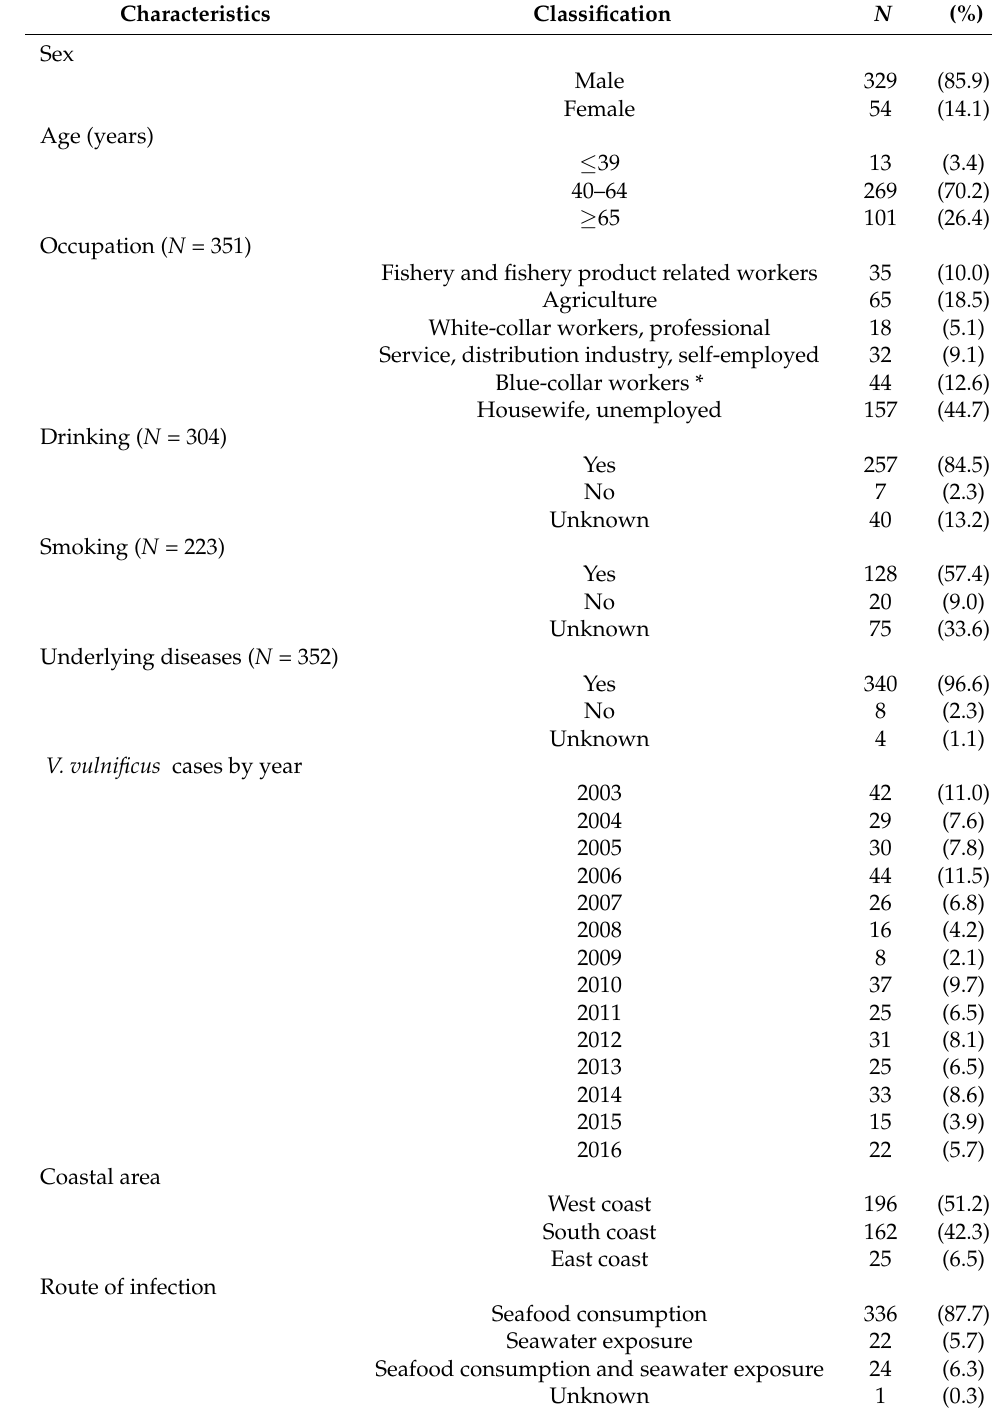
Table 1. General characteristics of the V. vulnificus cases ( N =